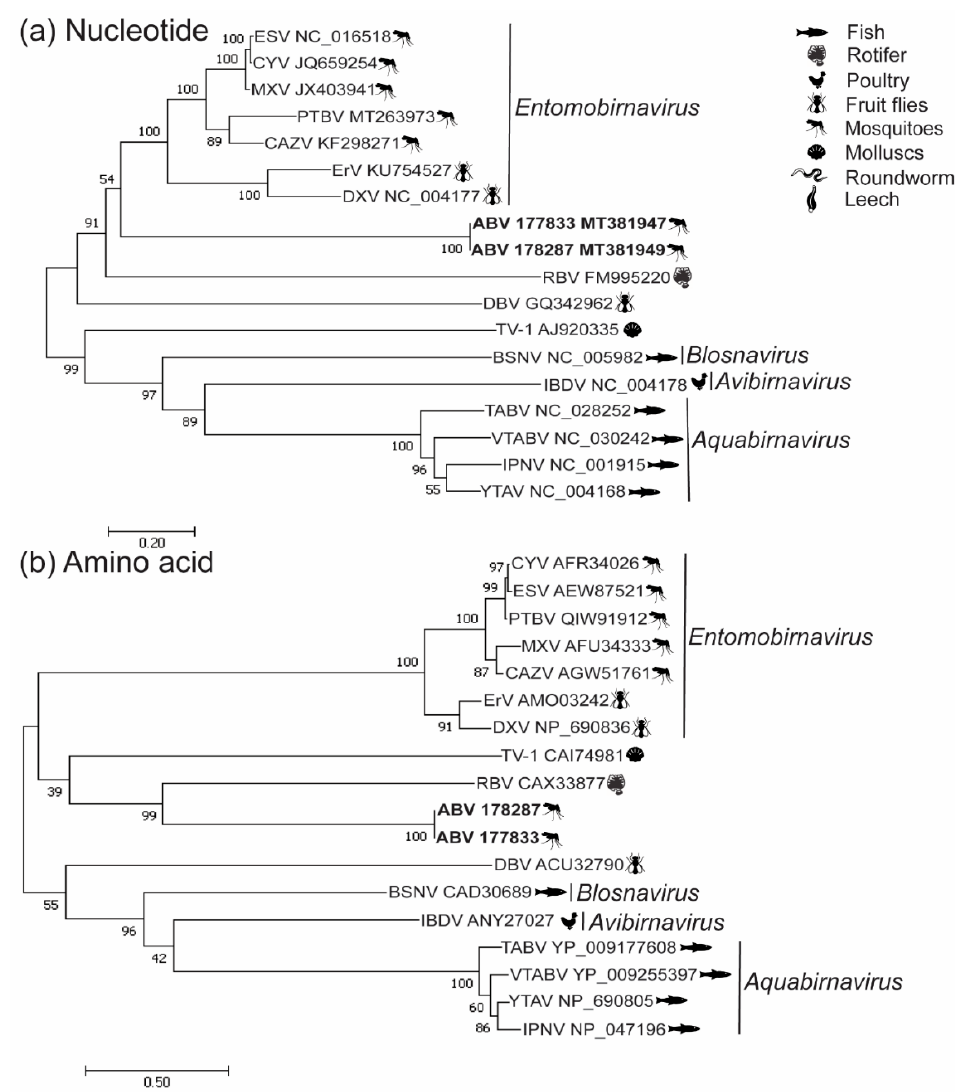
Figure 3. Phylogenetic analysis of ABV polyprotein. Unrooted maximum likelihood trees constructed from ( a ) nucleotide coding sequences (CDS) for birnavirus polyproteins aligned using the MUSCLE algorithm and ( b ) polyprotein amino acid sequences aligned with MAFFT. The broad host-species classification for each virus is by icons next to the virus name. Currently recognized genera are indicated in italics. Maximum likelihood analyses were performed in MEGA 7.0.26 using the general time-reversible (GTR) model with gamma distribution (5 categories ( + G, parameter = 1.8479)) and invariable variation for some sites ([ + I], 2.92% sites) for nucleotide sequences and the Jones–Taylor–Thornton (JTT) model with gamma substitutions and no deletions for amino acid sequences.